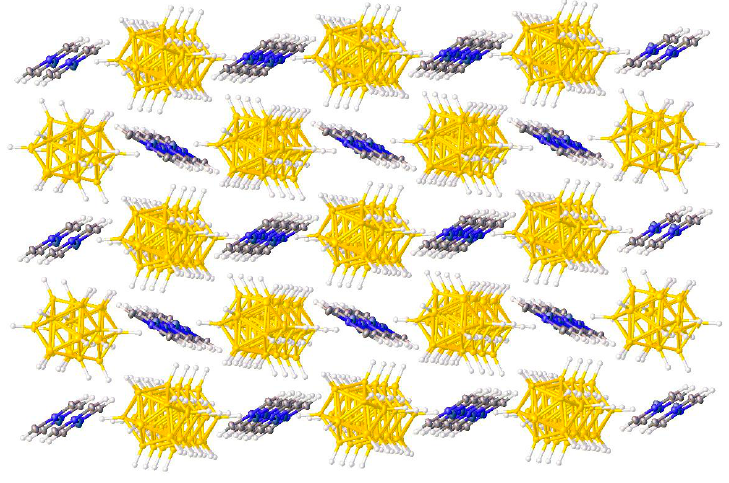
Figure 87. The crystal packing in X-ray structure of {Ag(pyz)[CB 11 H 12 ]} n .